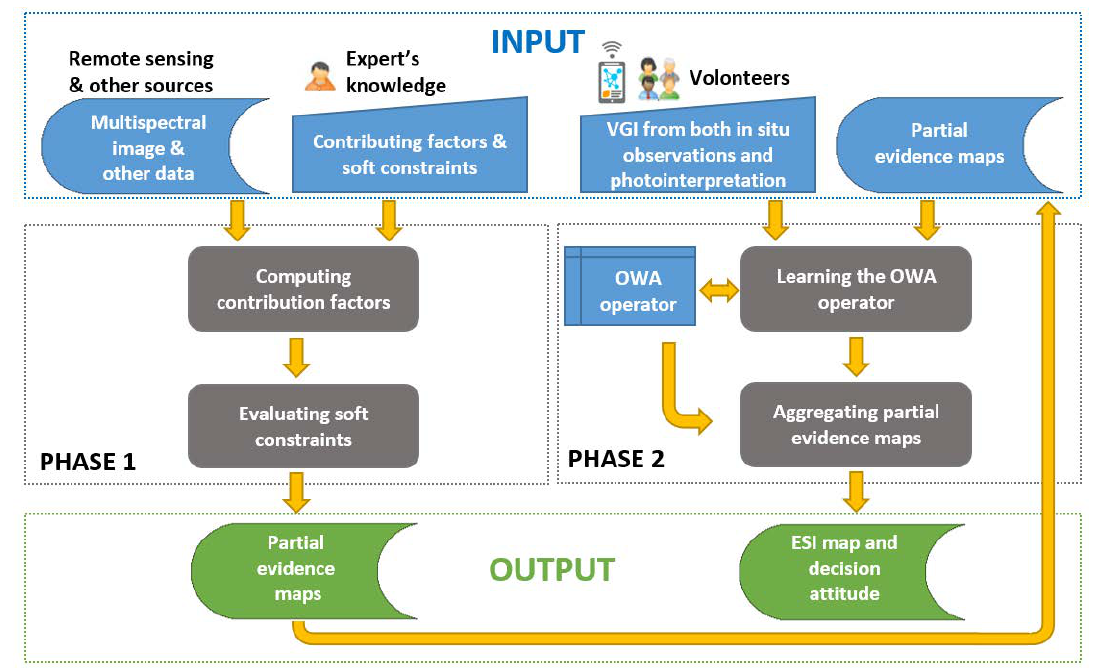
Figure 3. Workflow of the proposed soft computing adaptive approach for computing environmental status indicator (ESI) maps from remote sensing multispectral images, thematic information and VGI. While phase 1 exploits the expert’s knowledge, phase 2 is data-driven, exploiting VGI. The two phases are decoupled and communicate via the input